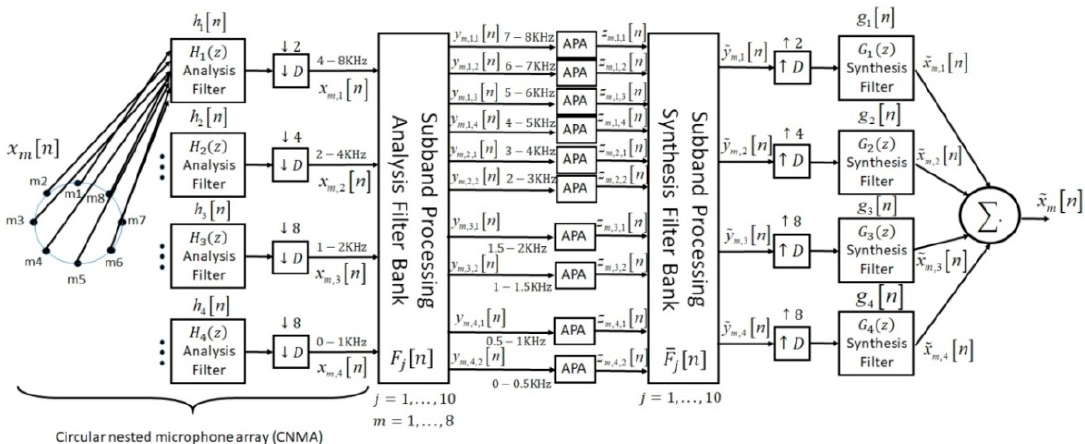
Figure 1. The block diagram of the proposed circular nested microphone array in combination with the sub-band affine projection algorithm (CNMA-SBAPA) for the speech enhancement.